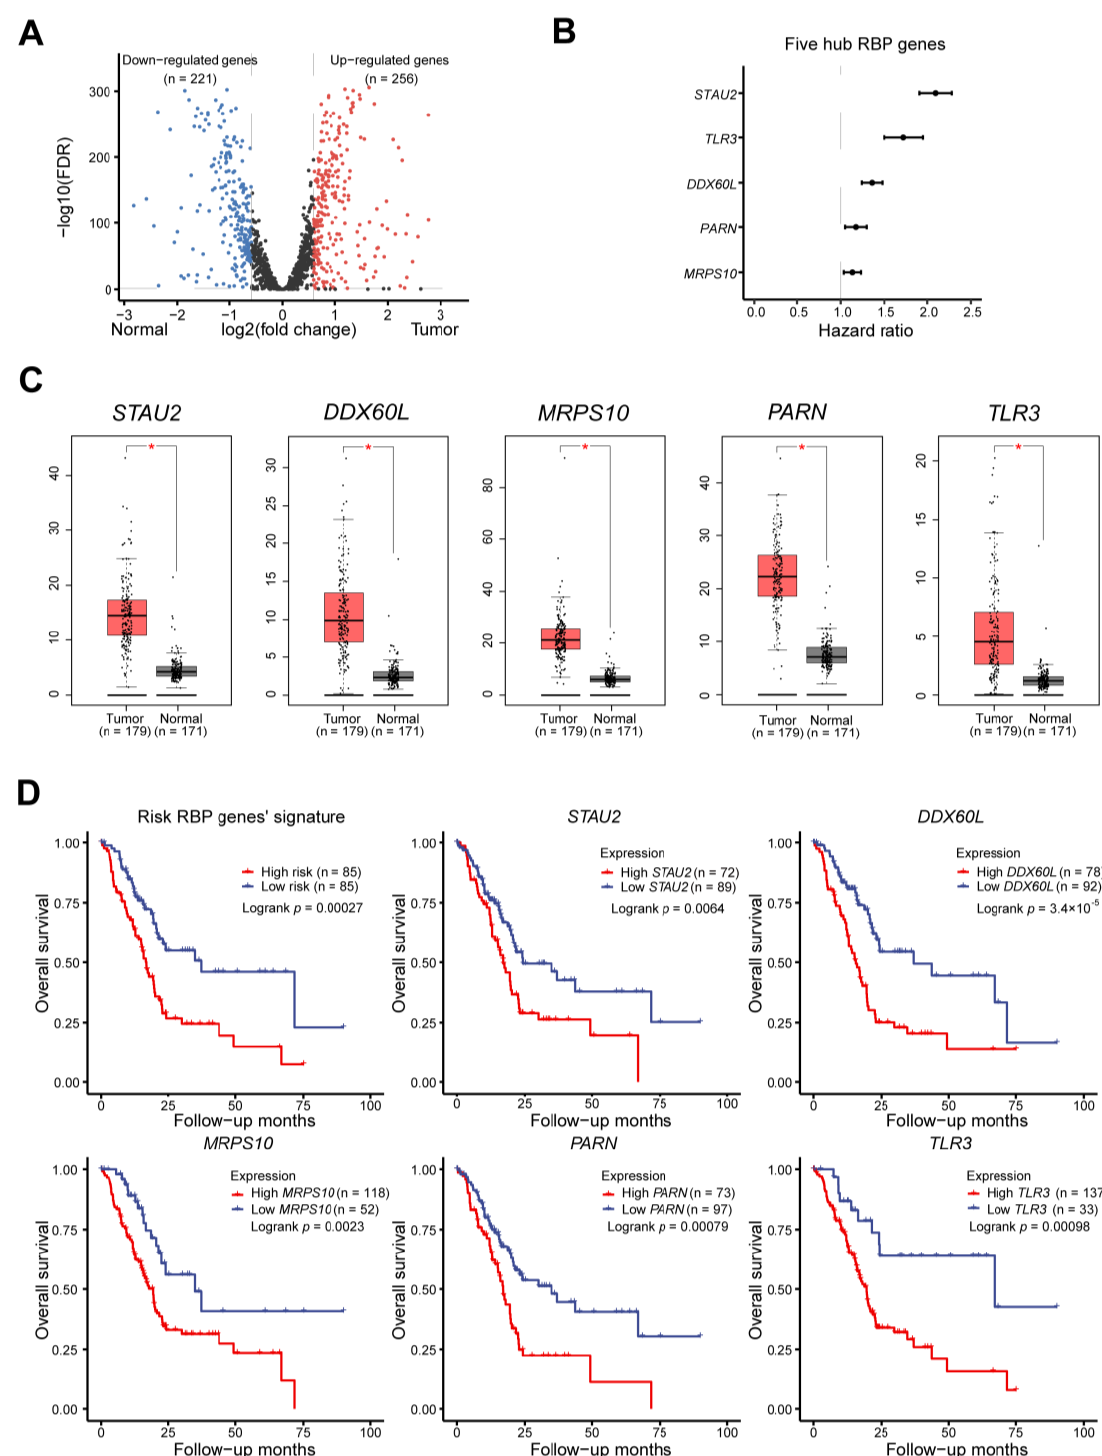
Figure 1. Identification of prognostic RBP signature. ( A ) Volcano plot shows that 477 RBP genes are significantly up- and down-regulated in PAAD patients. ( B ) Forest plots to show hazard ratios of the hub RBP genes, with prognostic values in PAAD based on data from TCGA. ( C ) Boxplots show a comparison of expression levels in TCGA tumor samples and GTEx normal tissues. The p -values were calculated using the unpaired Mann–Whitney Wilcoxon test, * p < 0.01. ( D ) The Kaplan–Meier plotter shows the relationship between RBP gene expression levels and overall survival in six prognostic PAAD